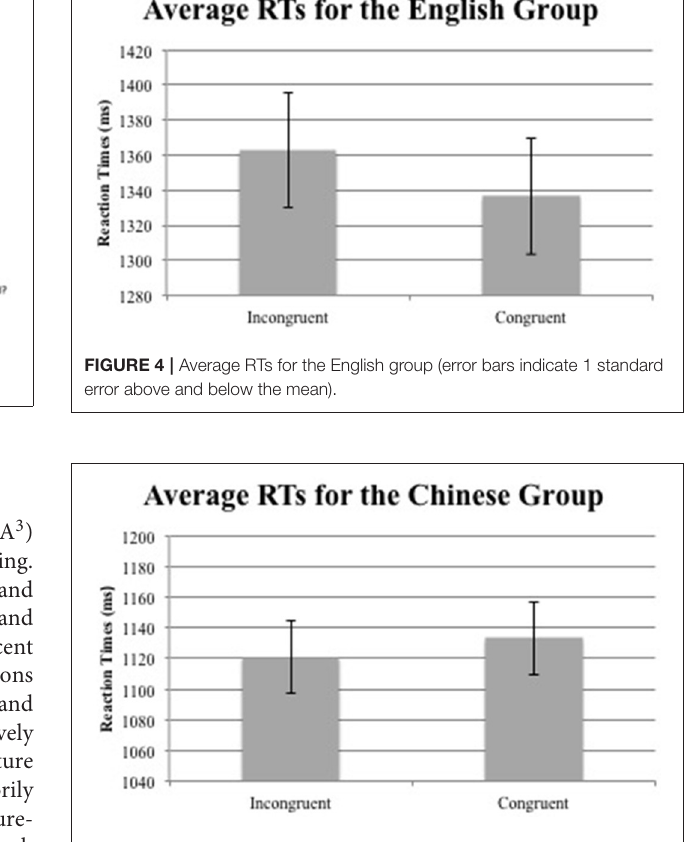
FIGURE 5 | Average RTs for the Chinese group (error bars indicate 1 standard error above and below the mean).